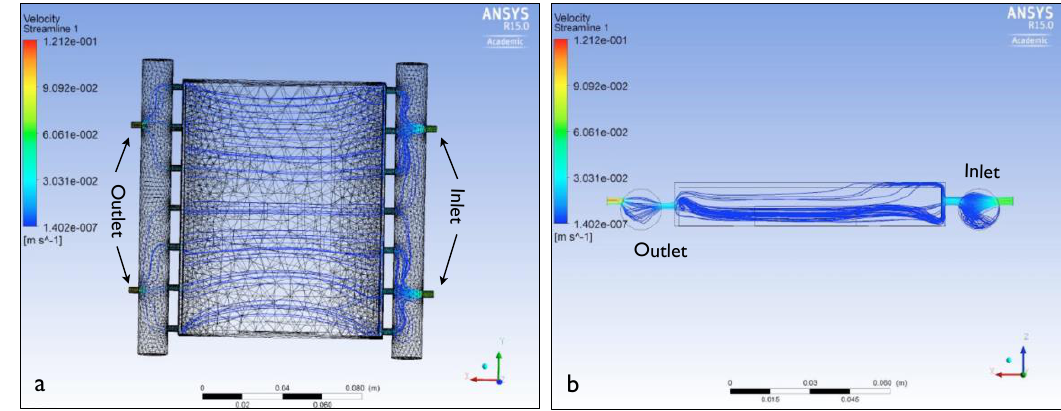
Figure 6. ANSYS model that simulates initial gas flows inside the growth chamber when the geometry of deflector shown in Figure 2f is included. ( a ) Top view and ( b ) side view. According to the GSD model the identity of the radical species determines the growth